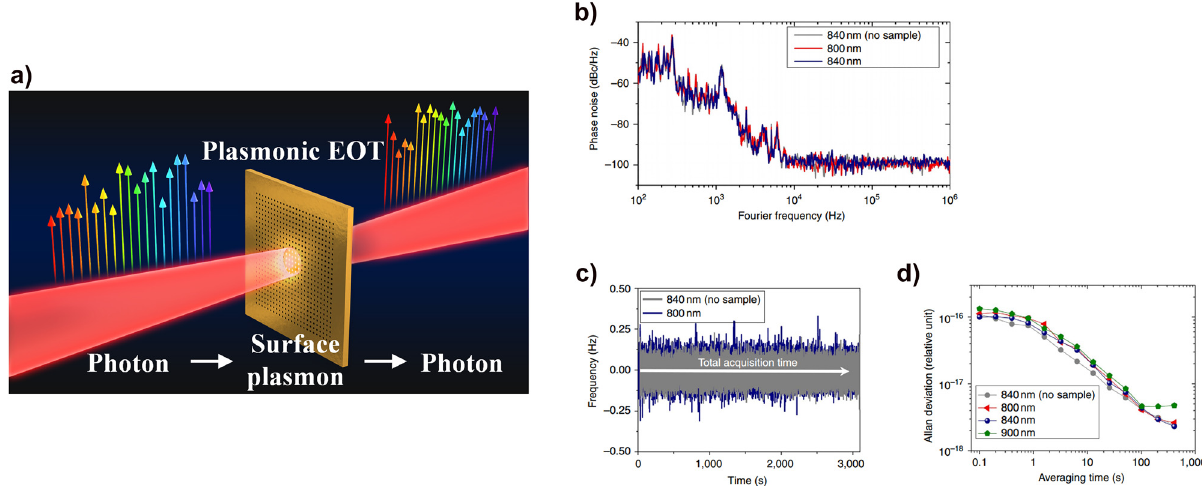
Figure 21: Plasmonic conversion of the optical frequency comb. (a) The frequency comb experiences photon-SP-photon conversion by passing through a plasmonic nanostructure. (b) – (d) analysis of the plasmonic frequency comb: phase noise and frequency stability. (b) Phase noise spectra at a 1.2 GHz RF carrier at three different cases; on- resonance wavelength of 840 nm, off-resonance wavelength of 800 nm, and without plasmonic EOT at the wavelength of 840 nm. (c) Time traceoftheRFbeatswithandwithouttheplasmonicEOTover3000s.(d)Allandeviationsoffrequencystabilitywithchangingtheaveragetime for different wavelength positions at on- and off-resonance conditions